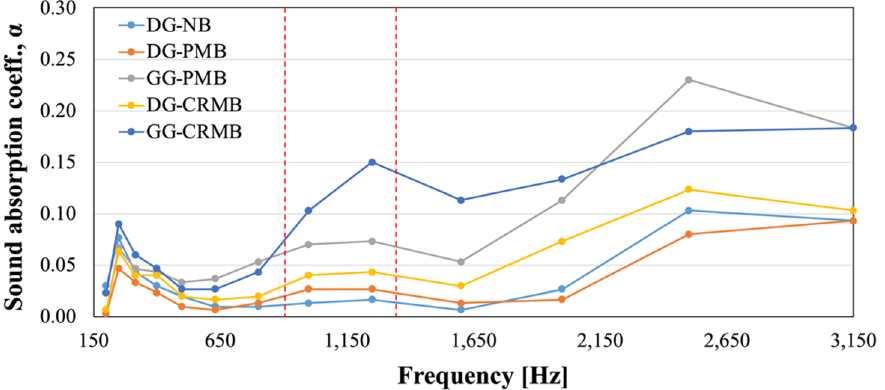
Figure 8. Sound Absorption Coefficients of Test Section Mixtures.